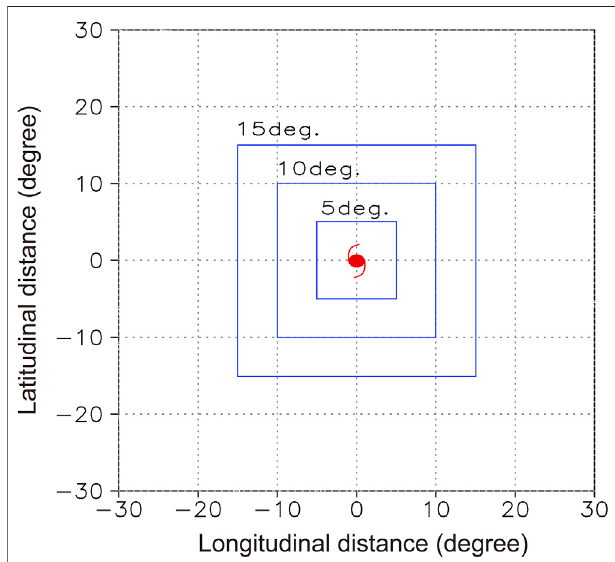
FIGURE 3 | Schematic diagram of the regional average calculation ranges of 5 ° , 10 ° and 15 ° . The centers of the composited TC cases are set as the origin of the coordinates (shown as the red TC symbol), which are positive (negative) tothe north(south) and east (west). The horizontaland vertical axes illustrate the horizontal distance in latitude and longitude from the composited TC center, which is the same in the following fi gures.